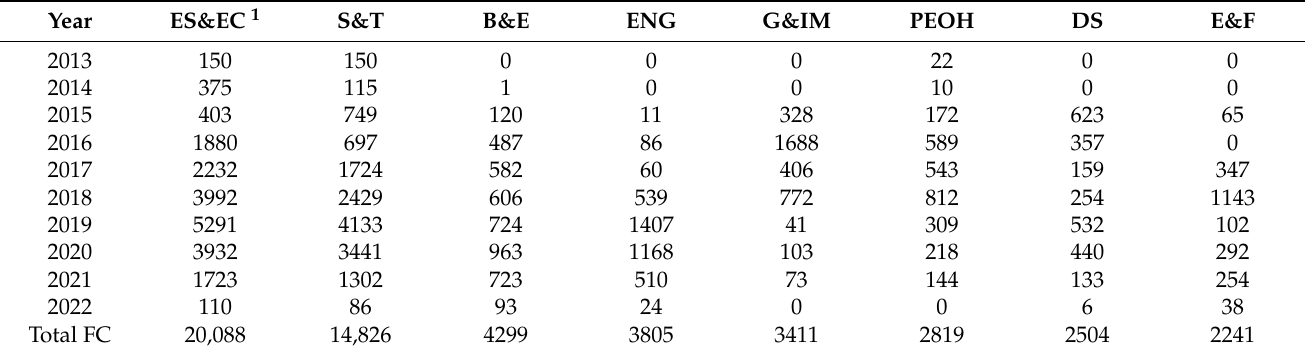
Table 6. The top eight fields with the most citations from 2013 to